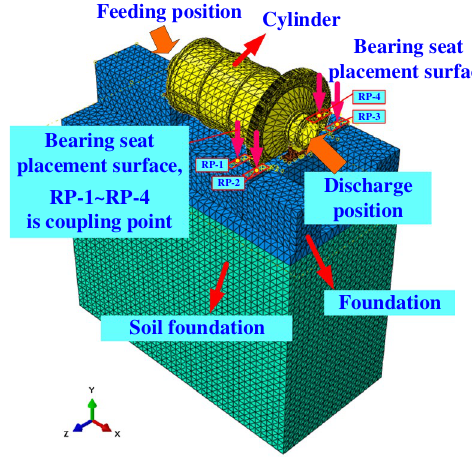
Figure 2. Finite element model of ball mill foundation.